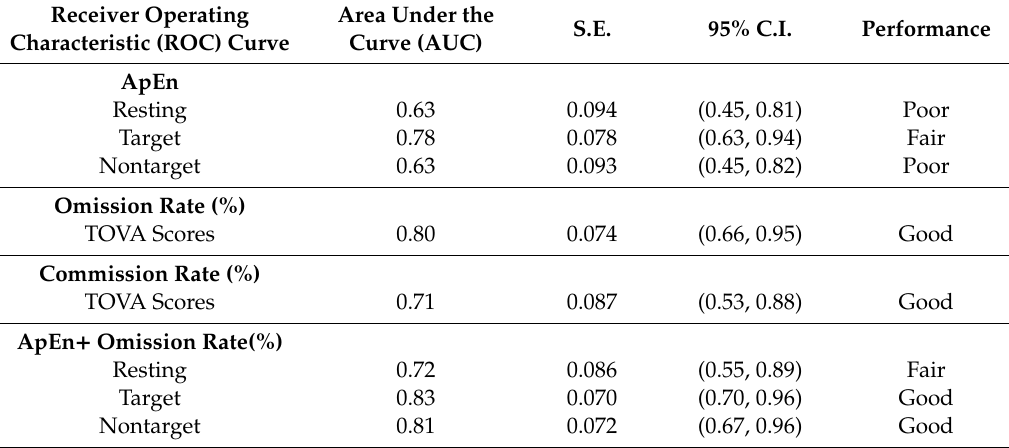
Table 4. Parameters of ROC curves of ApEn, omission rate (%), commission rate (%), and a combination of ApEn and omission